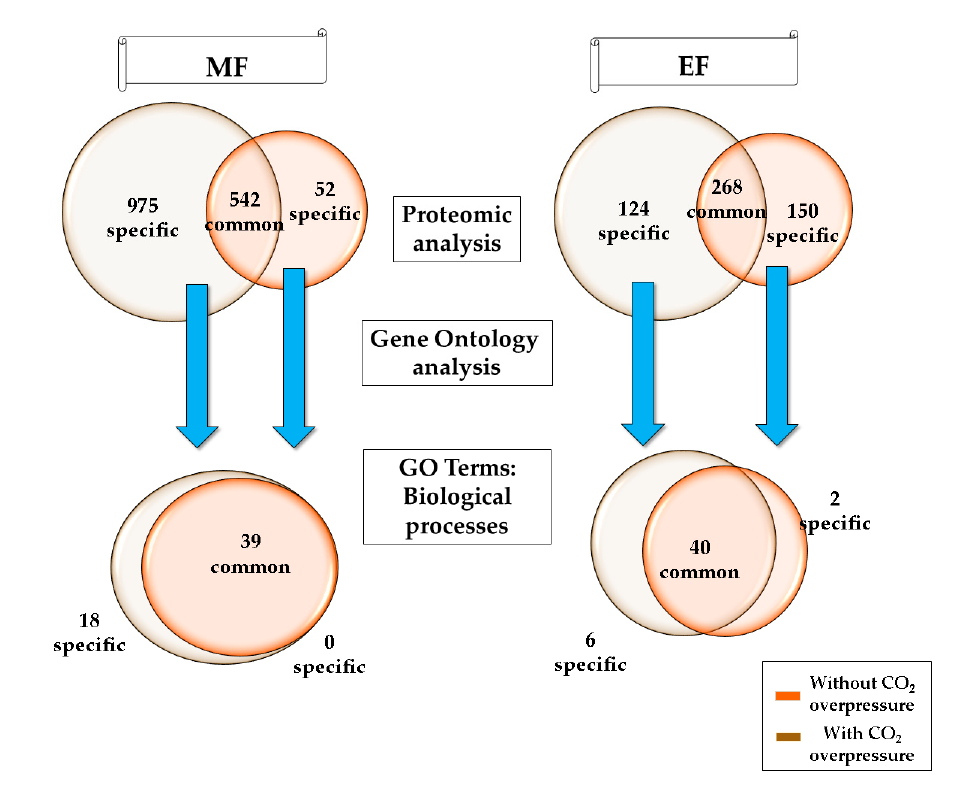
Figure 1. Venn diagram of proteins and Gene Ontology (GO) terms related to the biological processes under two experimental conditions: without and with CO 2 overpressure at the middle (MFP ( − ) and MFP (+), respectively) and the end of fermentation under real second fermentation conditions (EFP ( − ) and EFP (+), respectively).